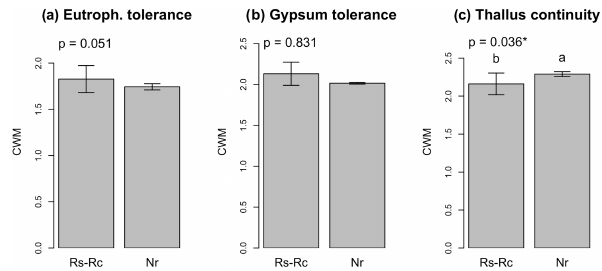
Figure 3. CWMs ( ± SE) for eutrophication tolerance (“eutroph. tolerance”), gypsum tolerance and thallus continuity. Rs-Rc: road- cut; Nr: natural remnants. The significance value of the Kruskal– Wallis test is given for each graph. Different letters indicate sig- nificant differences (Conover–Iman test for post hoc comparisons, p < 0 . 05) among environmental